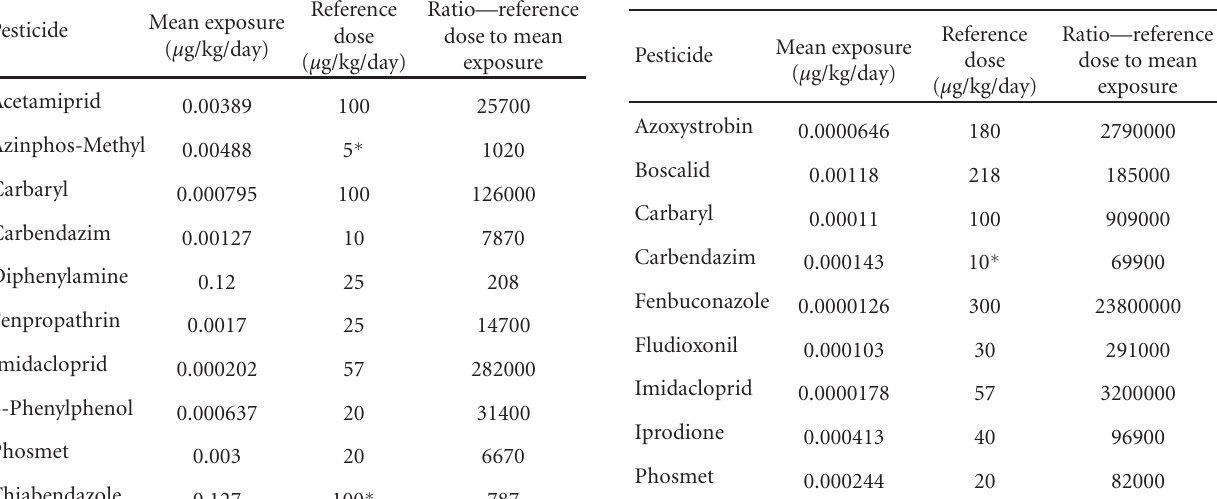
Table 4: Exposure estimates of the ten most frequently detected pesticides on